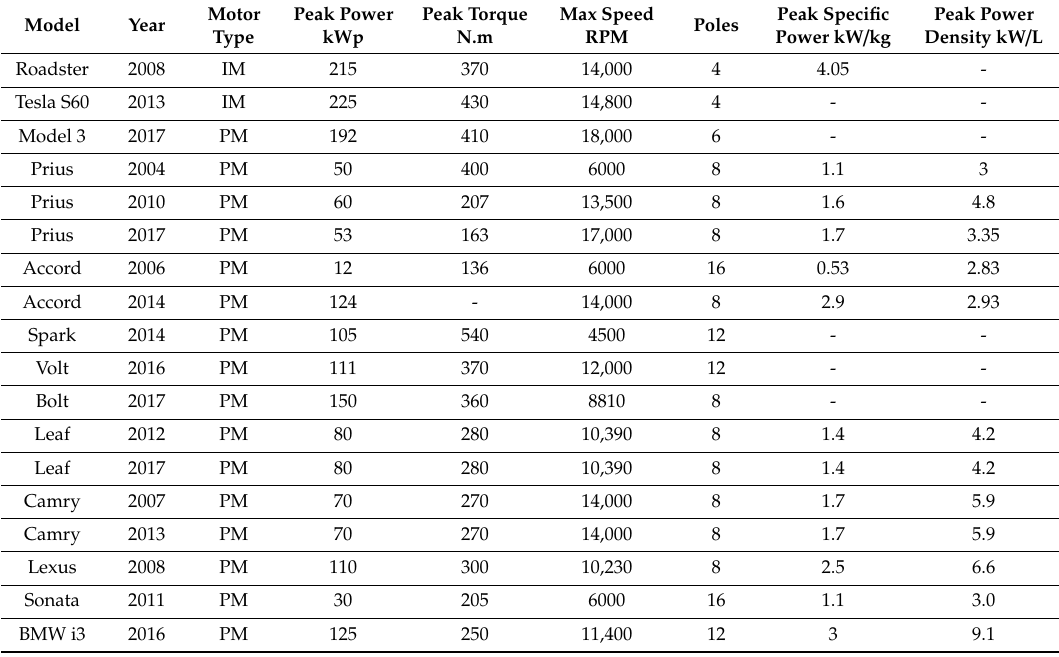
Table 1. Traction machine specifications